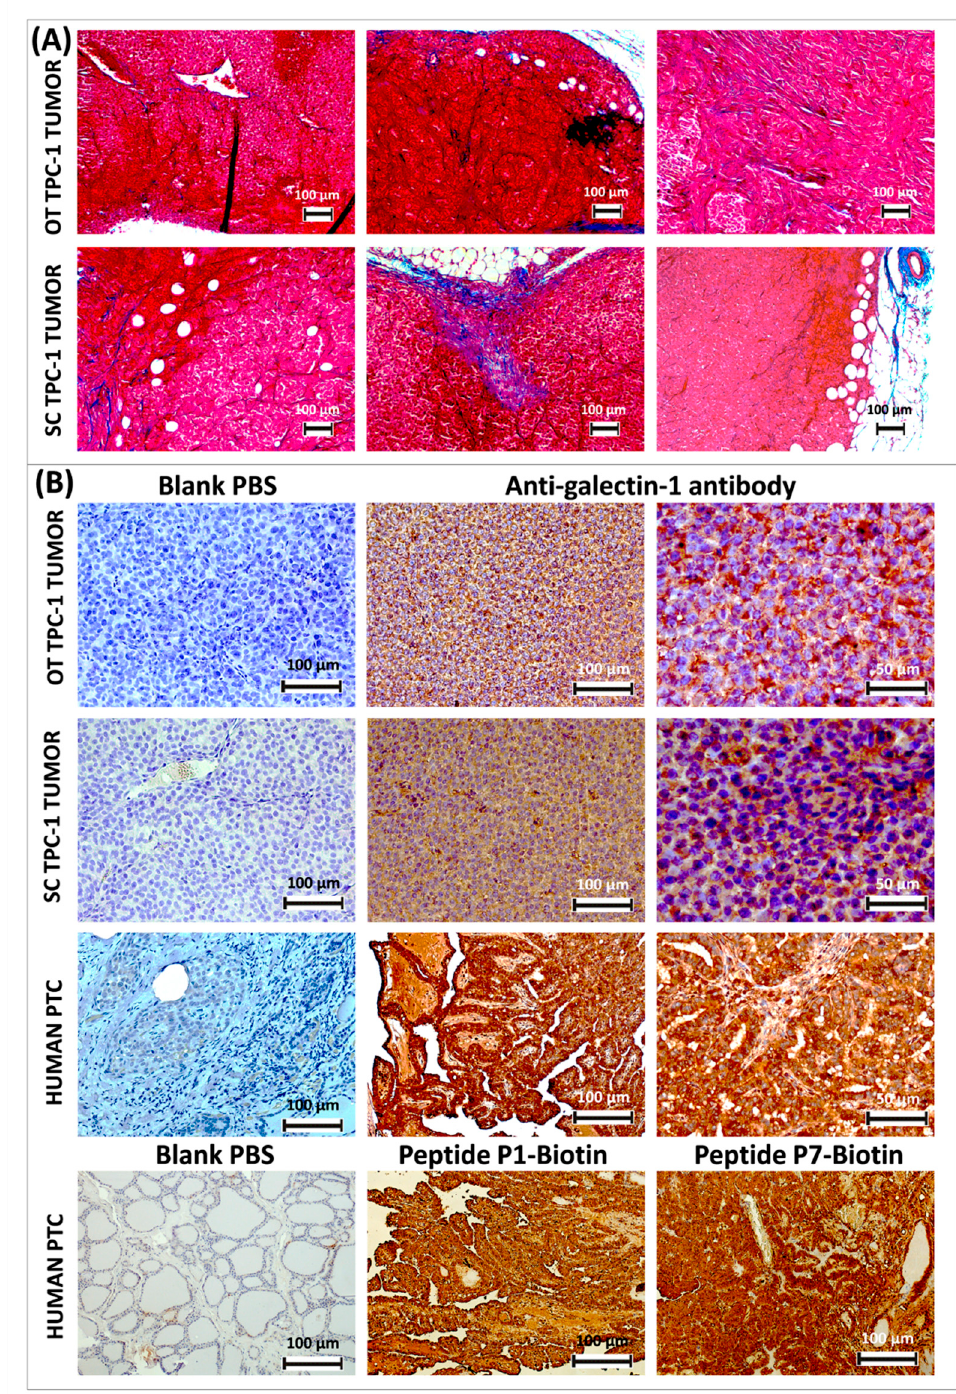
Figure 4. Masson’s trichrome staining of thyroid papillary carcinoma-1 (TPC-1) tumors developed in athymic nude mice orthotopically (OT) at the neck level and subcutaneously (SC) at the thigh level; cytoplasm is stained in red; the collagen is stained in blue ( A ). Immunohistochemical analysis of gal-1 expression (stained in brown) in TPC-1 tumors developed in athymic nude mice and comparison with a case of human papillary thyroid cancer, where gal-1 is immunostained either by anti-gal-1 antibody or by biotinylated peptides P1 and P7; histological sections are counter-stained with Mayer’s hemalum ( B ).